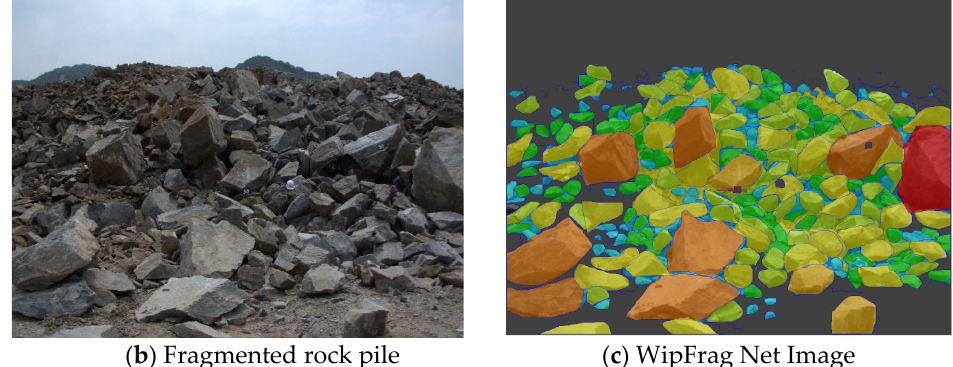
Figure 14. Rock pile image, contouring, histogram, and cumulative size curve of the fragmented block (bench front image of sand stemming case after blasting).